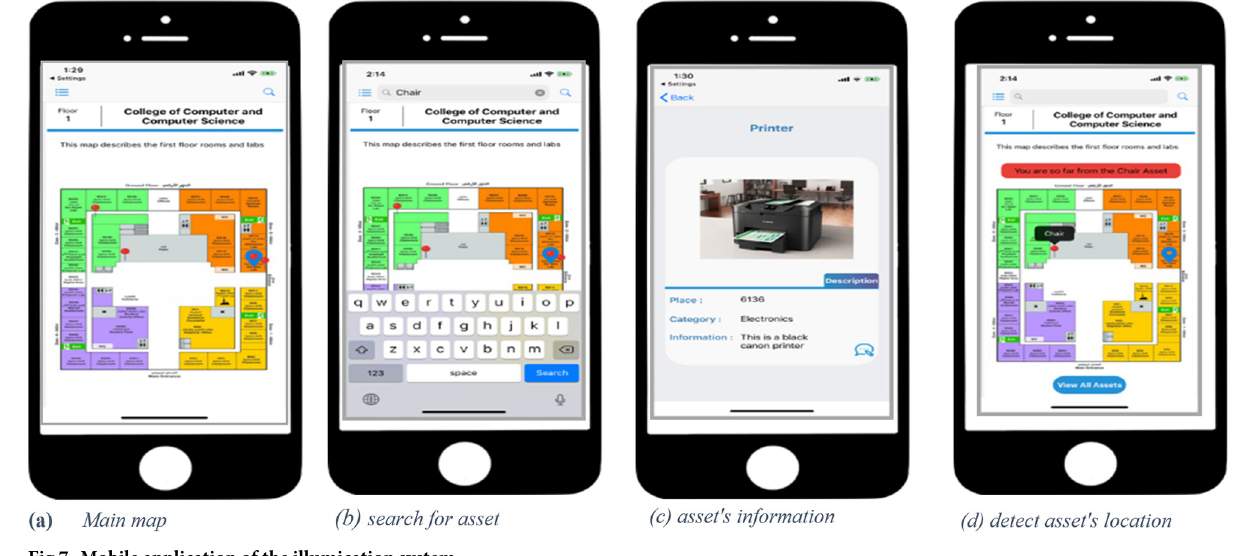
PLOS ONE | https://doi.org/10.1371/journal.pone.0274452 September 29,